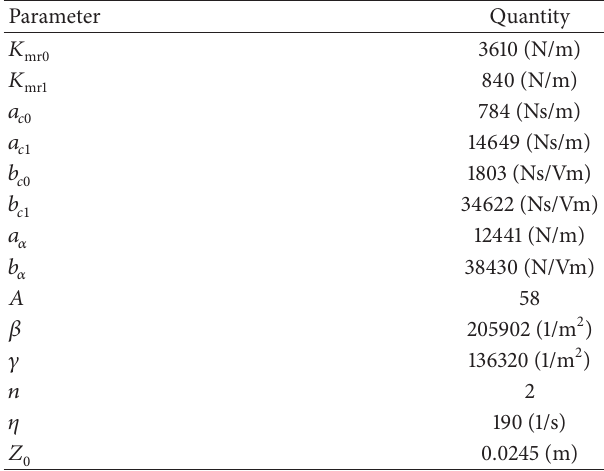
Table 1: Parameters of MR damper